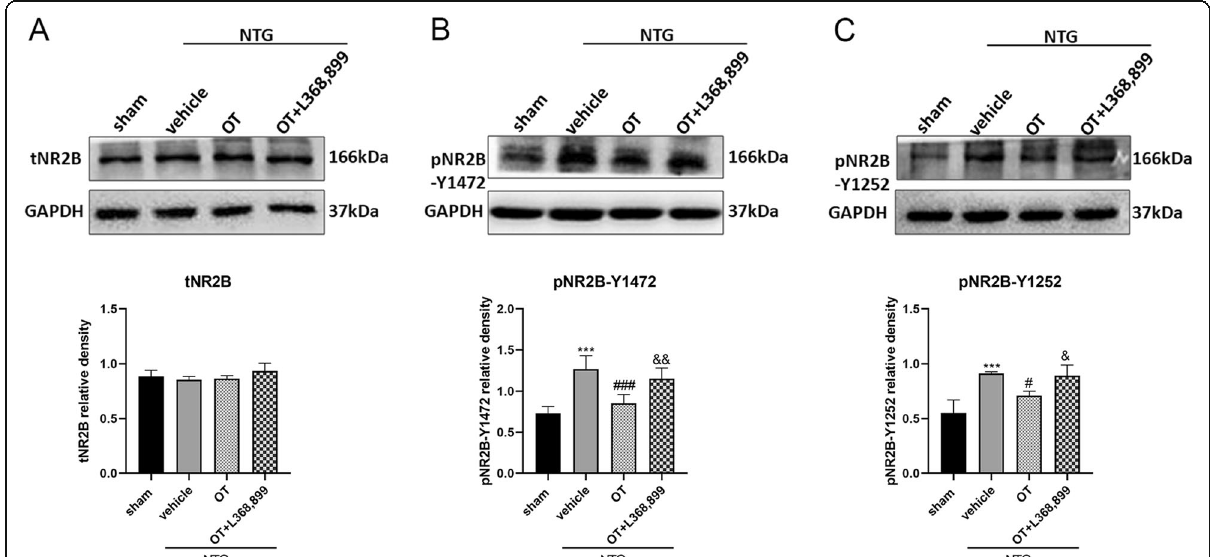
Fig. 5 Effect of OT on phosphorylated NR2B expression levels. A Representative WB bands showed that there was no significant difference in total NR2B expression among the four groups. B and C The protein levels of pNR2B-Y1472 ( B ) and pNR2B-Y1252 ( C ) were significantly elevated in the NTG + vehicle group compared with the sham group. After OT treatment, the expression levels of these two proteins were significantly reduced. These effects of OT were inhibited by L368,899. One-way ANOVA with Dunnett ’ s post hoc test, n = 6/group; *** p < 0.001 vs. the sham group; # p < 0.05, ### p < 0.001 vs. the NTG + vehicle group; & p < 0.05, && p < 0.01 vs. the NTG + OT